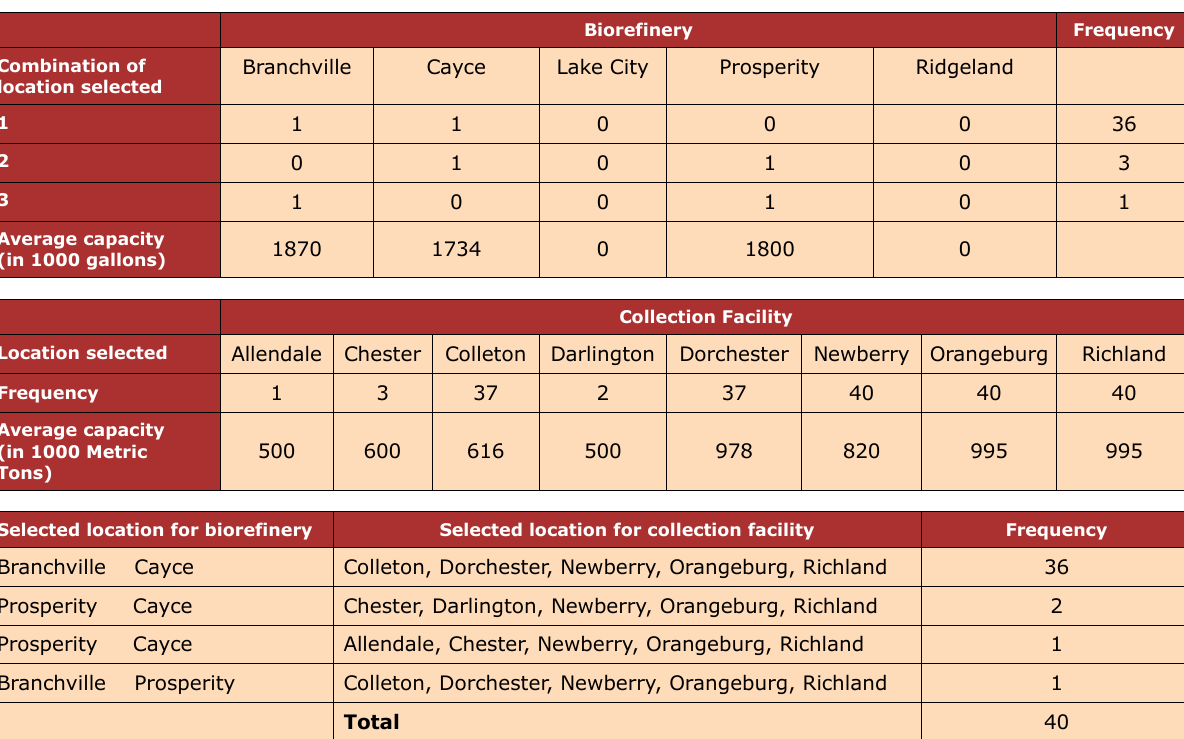
Table 2d. Simulation Results of Locations of Biorefinery and Collection Facility for Case 3 (Left-Skewed Triangle